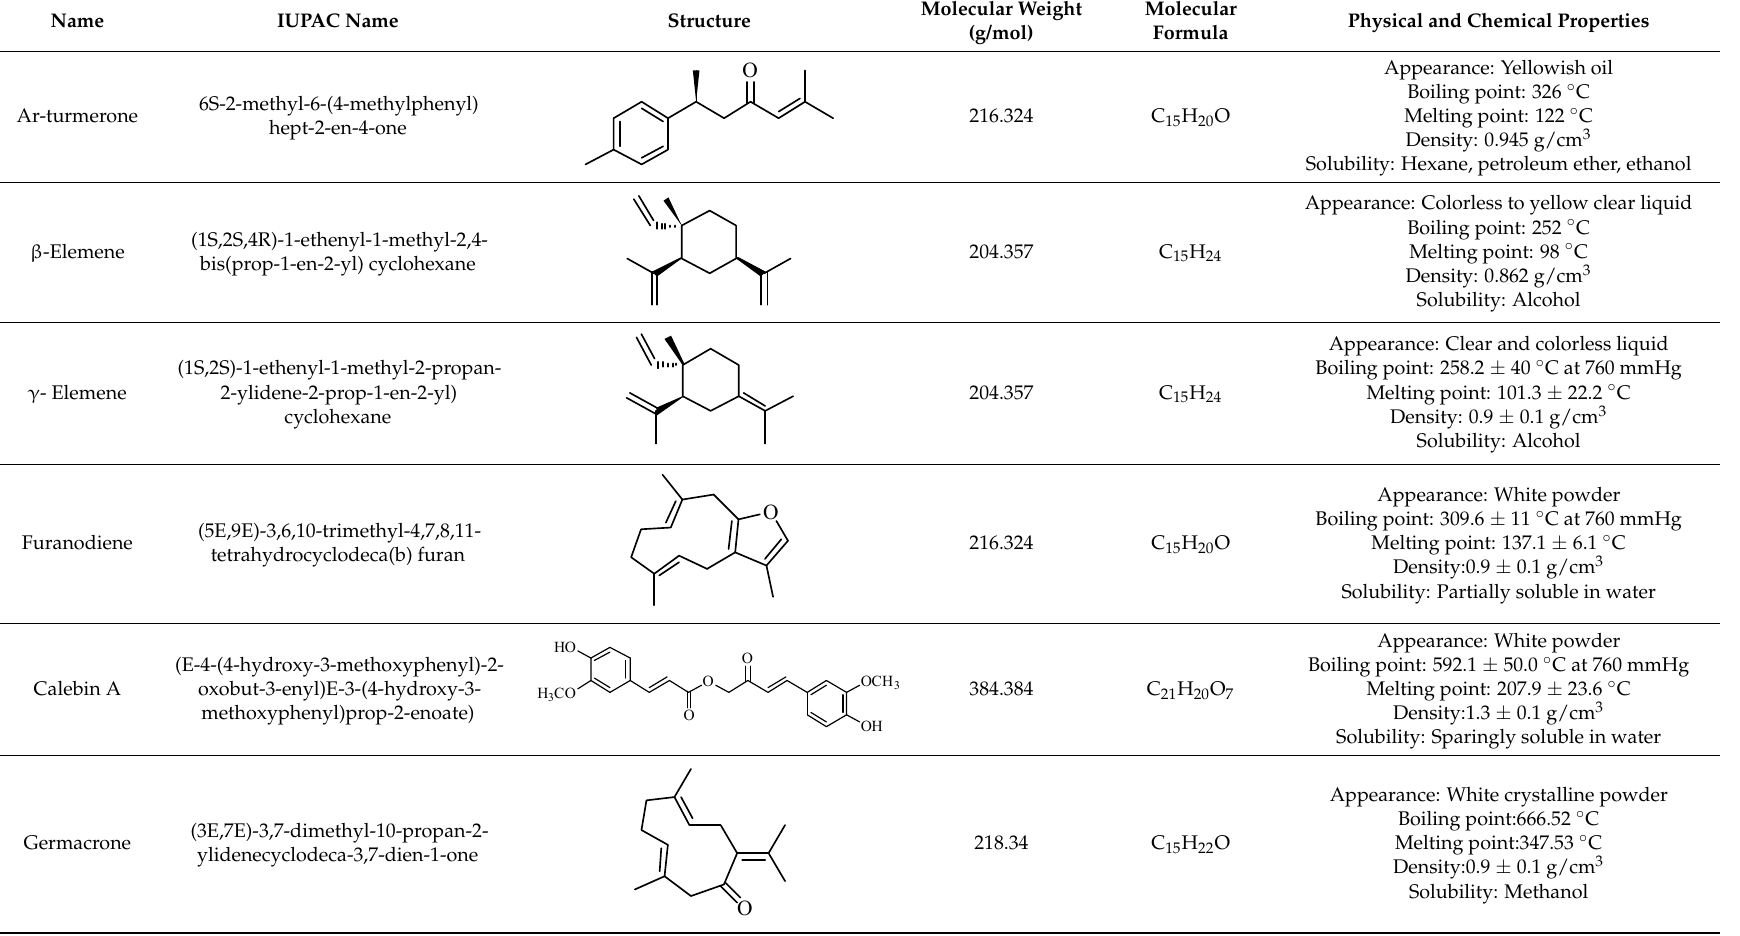
Table 1. Chemical structures and physicochemical properties of selected non-curcuminoids.